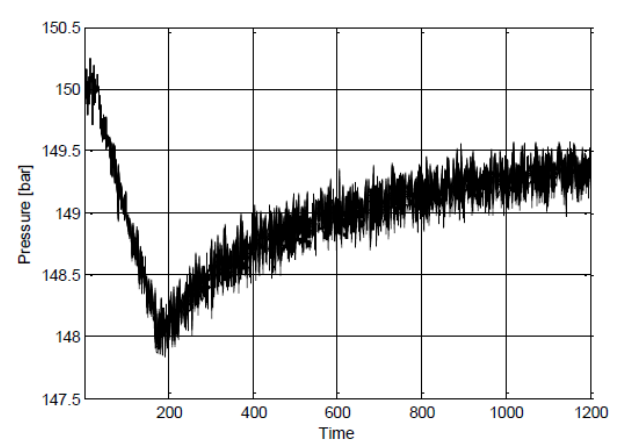
Fig. 19. Pressure profiles of trajectories belonging to cluster